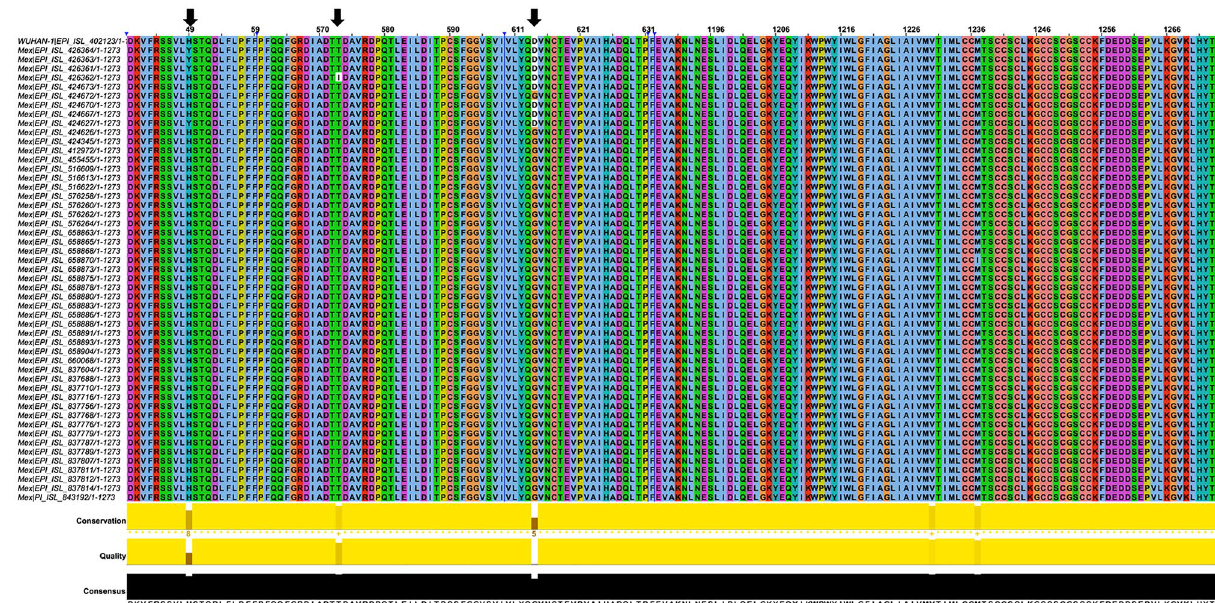
Figure 1. Multiple sequence alignment of Spike SARS-CoV-2 protein. The Wuhan Spike sequence was taking as wild type, the rest of the sequences correspond to Mexican Population. Arrows (black) indicate the row where the mutations were observed. The head of the arrows (blue) shows the hidden